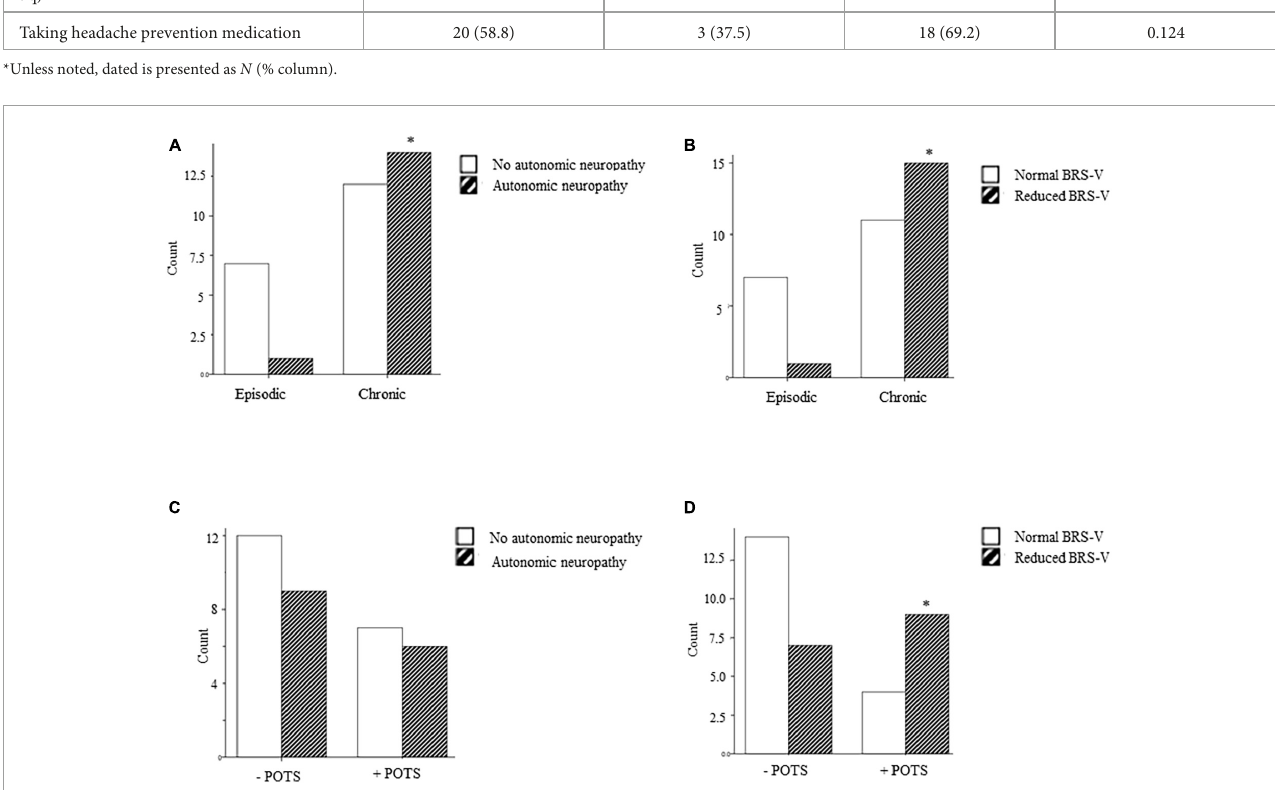
FIGURE1 (A–D) Frequency of autonomic dysfunction (CASS ≥ 3), and reduced cardiovagal baroreflex sensitivity (BRS-V) in patients with episodic and chronic headache and with and without POTS. ∗ = main effect, p <